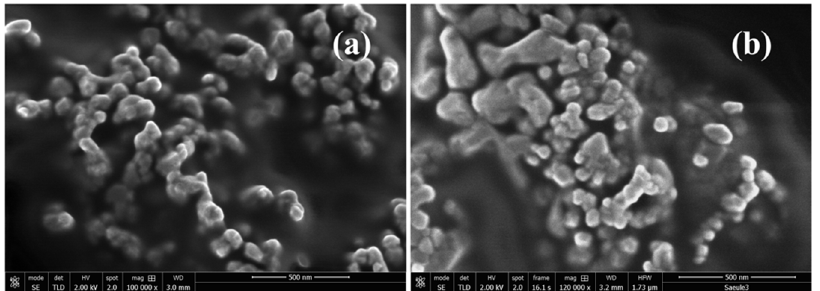
Figure 2. SEM micrographs of ( a ) CaMnO 3 (CMO) and ( b ) Pr 1-x Ca x MnO 3 (PCMO). The average particle size was 70 and 64 nm for CMO and PCMO, respectively.